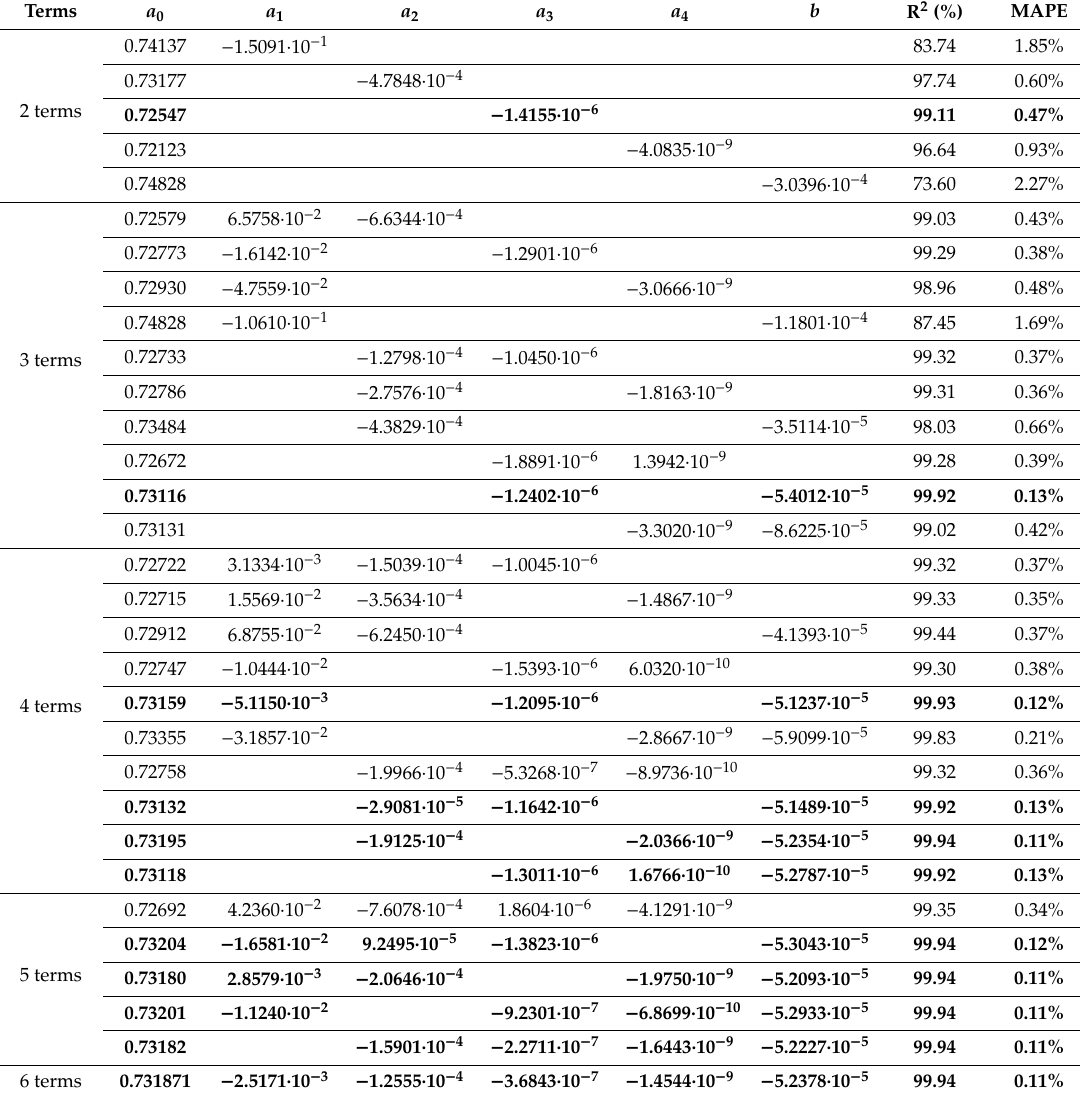
Table 3. Evaluation indexes for the examined formulas (The empty cells indicate that the respective term is not taken into account and the bold lines indicate the best